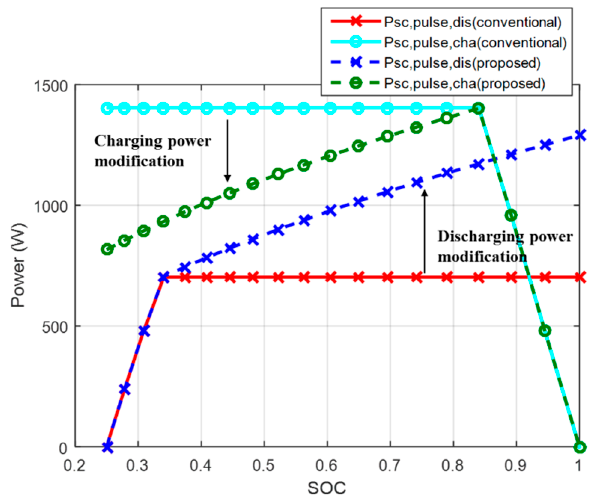
Figure 15. The pulse power capability of the supercapacitor for 1 second using the proposed method.